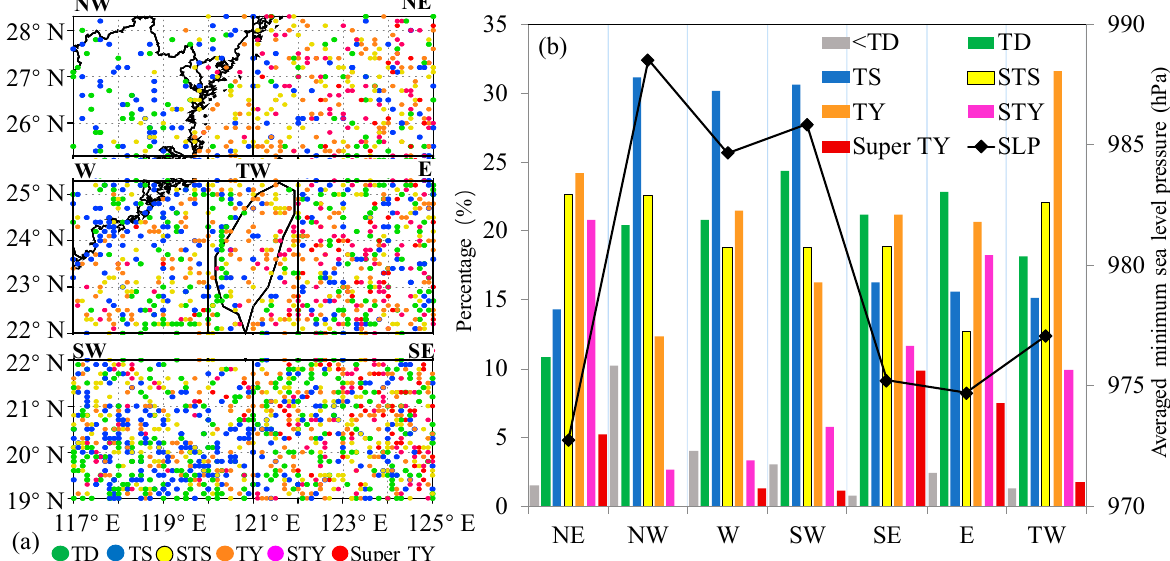
Figure 2. ( a ) TC samples in different intensity categories from 1979 to 2021. One dot denotes the center of a TC in the study region, and its intensity category is represented by its color, i.e., green dot for Tropical Depression (TD), blue dot for Tropical Storm (TS), yellow dot for severe tropical storm (STS), orange dot for Typhoon (TY), pink dot for severe typhoon (STY), and red dot for Super Typhoon (Super TY). The study area is divided into subregions by black lines (black letters indicate the name of the subregion): northeast of the island (NE), northwest of the island (NW), west of the island (W), southwest of the island (SW), southeast of the island (SE), east of the island (E), and Taiwan Island (TW). ( b ) Probabilities of TC intensity categories and averaged minimum sea level pressure of TC in each subregion.